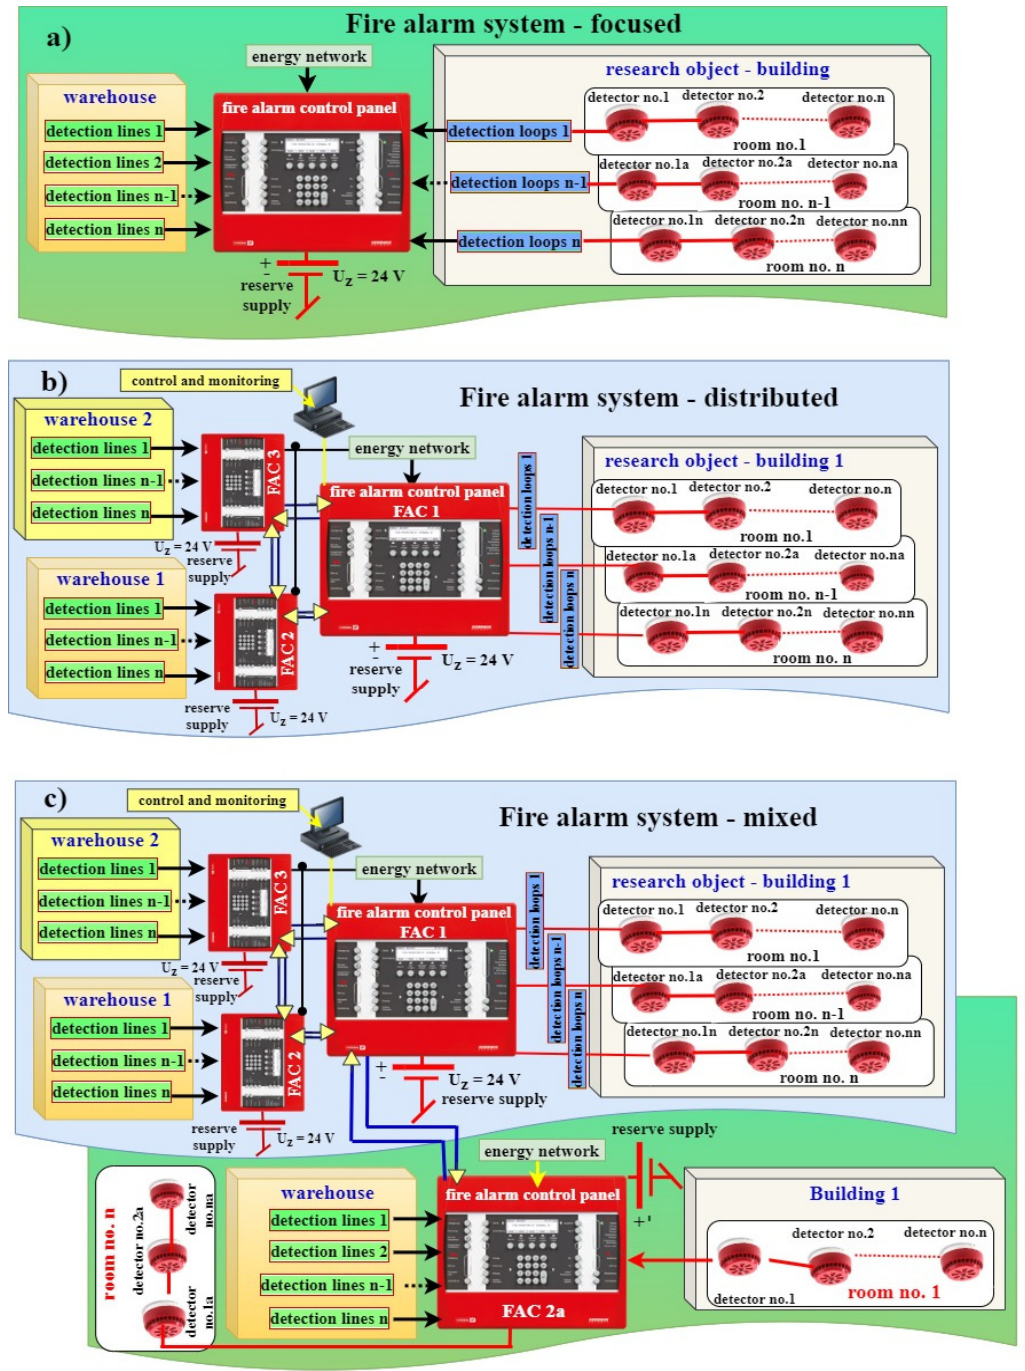
Figure 2. Configuration of fire alarm systems in buildings and structures of the so-called critical infrastructure: ( a ) simple- structure FAS, ( b ) distributed-structure FAS, ( a , c ) mixed-structure FAS, where U z = 24 V — supply voltage for FAS, FAC 1, FAC 2, FAC 3, FAC 2a — power supply through fire alarm control units (FACU); building, warehouse, warehouse 1, warehouse 2 — critical infrastructure building areas monitored by detection circuits and lines with fire detectors of successive addresses: 1, 2, n − 1, n; 1a, 2a, n − 1a, na,…,1n, 2n, n − 1n,…,nn; room No. n — monitored only by a B-type radial line as a separate fire zone, with a switching station supplying the entire vast facility of the so-called critical infrastructure.